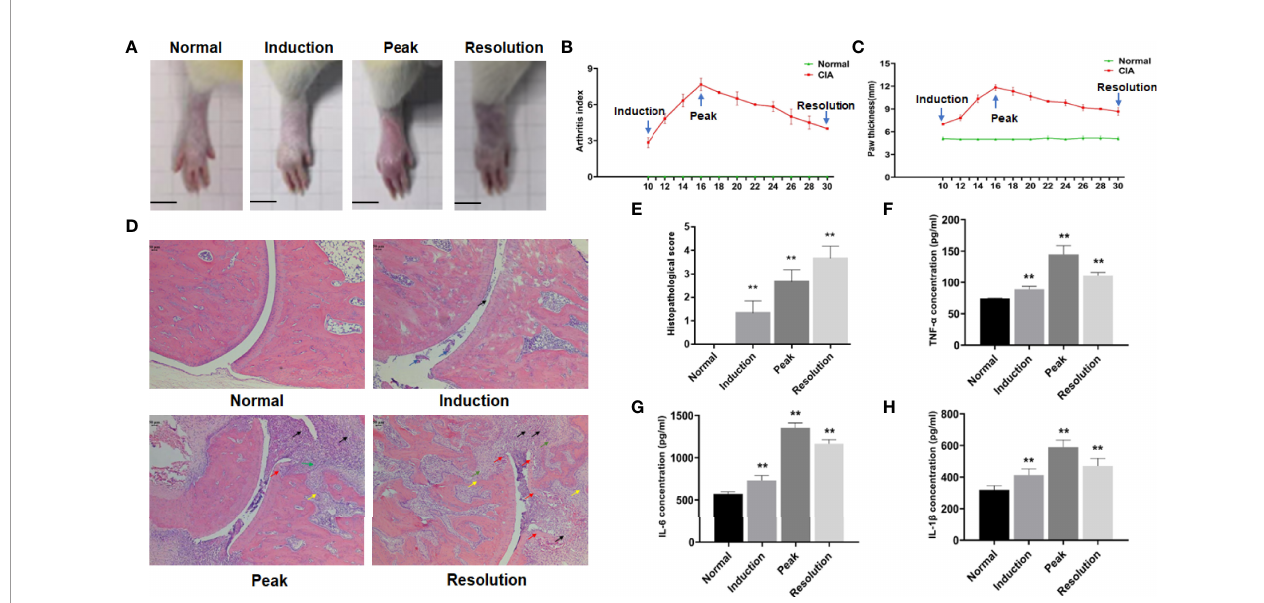
FIGURE 1 | The dynamic changes of arthritis in collagen-induced arthritis (CIA) rats. (A) Photographs of the hind paw and ankle joint of rats. (B) Arthritis score. (C) Hind paw thickness, scale bar = 1 cm. (D) The representative histopathological fi nding of the ankle joint from each group (×50), scale bar = 50 m m. The black arrow indicated in fl ammatory cell in fi ltration, the blue arrow indicated synovial hyperplasia, the green arrow indicated pannus formation, the yellow arrow indicated bone destruction, and the red arrow indicated cartilage erosion. (E) Histopathological score. ( F – H ) The levels of TNF- a , IL-6, and IL-1 b in the serum of rats from each group. Data were mean ± SD. N = 6. ** p < 0.01 compared with the normal